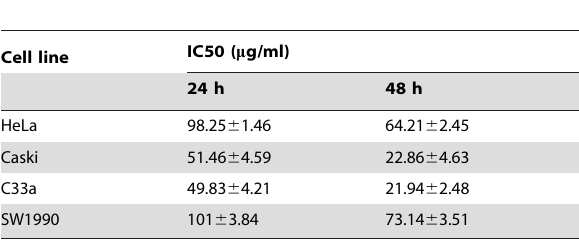
Table 1. Concentration producing 50% growth inhibition (IC50) of TCS on cancer